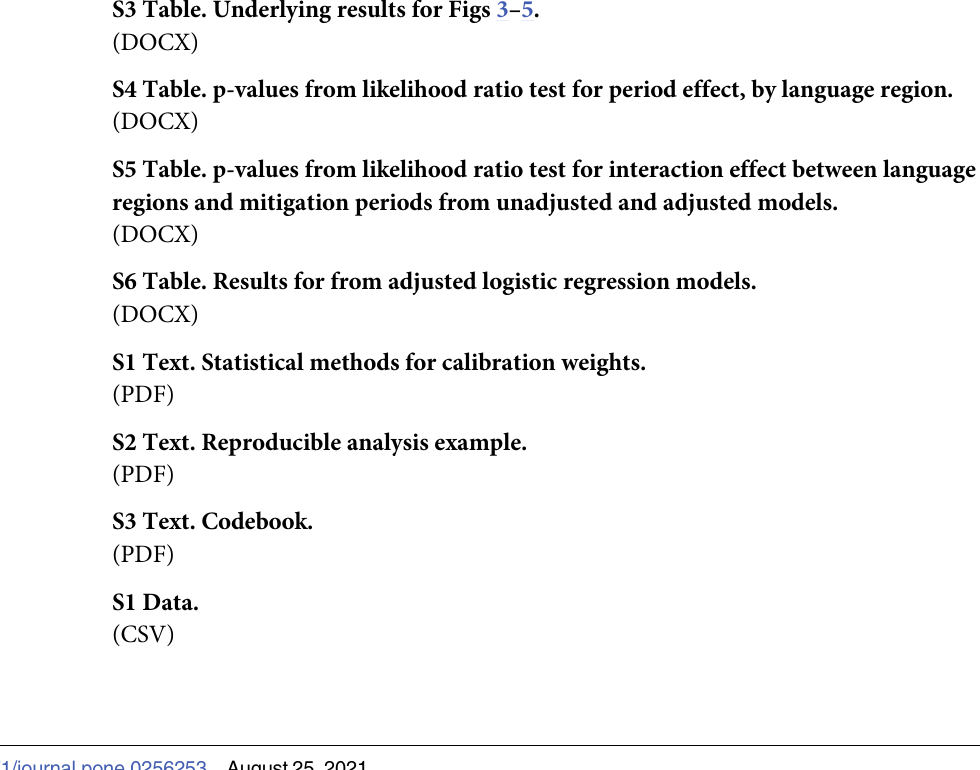
S1 Table. The domain, the source and the original question from the survey questionnaire. S2 Table. Description of missing values. S3 Table. Underlying results for Figs 3–5. S4 Table. p-values from likelihood ratio test for period effect, by language region. S5 Table. p-values from likelihood ratio test for interaction effect between language regions and mitigation periods from unadjusted and adjusted models. S6 Table. Results for from adjusted logistic regression